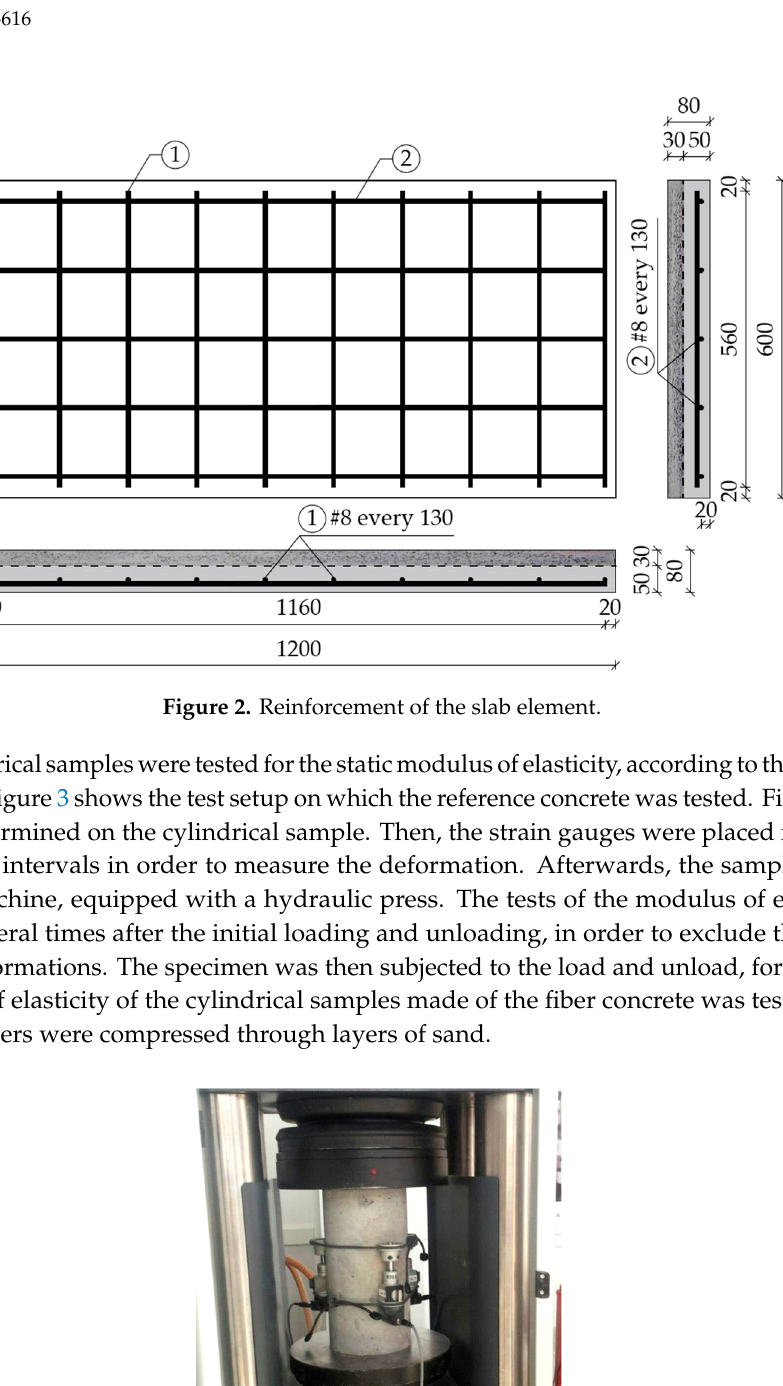
Figure 2. Reinforcement of the slab element.